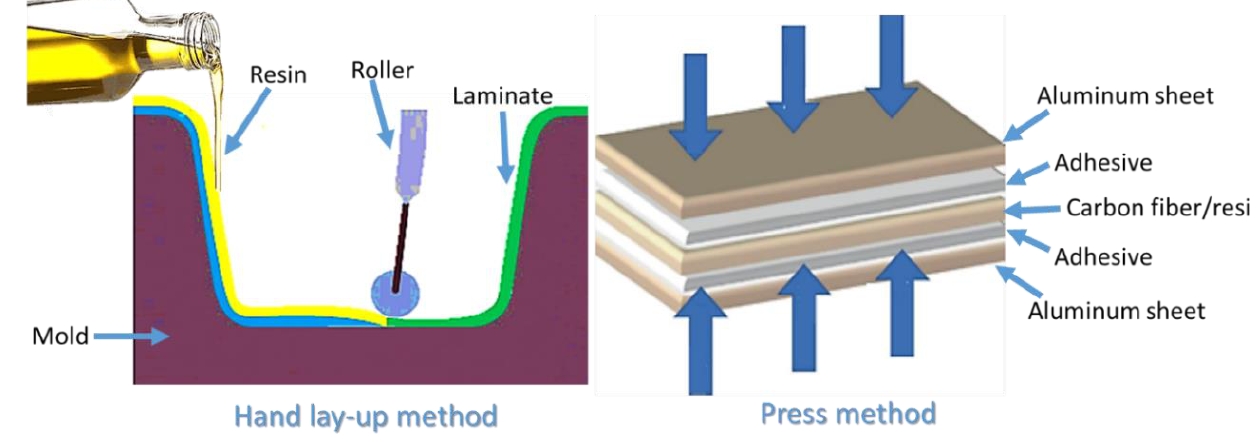
Figure 3. Hand lay-up and press methods for sandwich composite